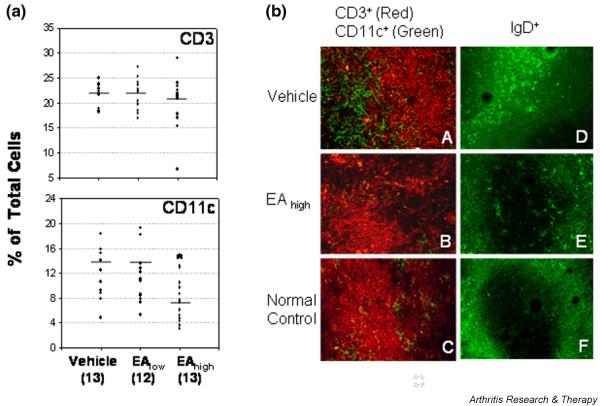
Changes in splenic mononuclear cells as a result of treatment with the ethyl acetate (EA) extract of Tripterygium wilfordii Hook F (TwHF). (a) Flow cytometric analysis of spleen mononuclear cells from NZB/WF1 mice after treatment with vehicle or the EA extract of TwHF. Horizontal bars indicate the median value for each group. Numbers of mice analyzed are indicated in parentheses. *p < 0.05, EAhigh versus vehicle. (b) Immunohistochemical analysis of spleen from NZB/WF1 mice after treatment with vehicle (A,C) or the EA extract of TwHF (B,D). CD3+ cells (red) and CD11c+ cells (green) are shown in (A,B,C) and IgD+ cells shown in (D,E,F). Results shown are representative of five mice per group. Original magnification × 400.